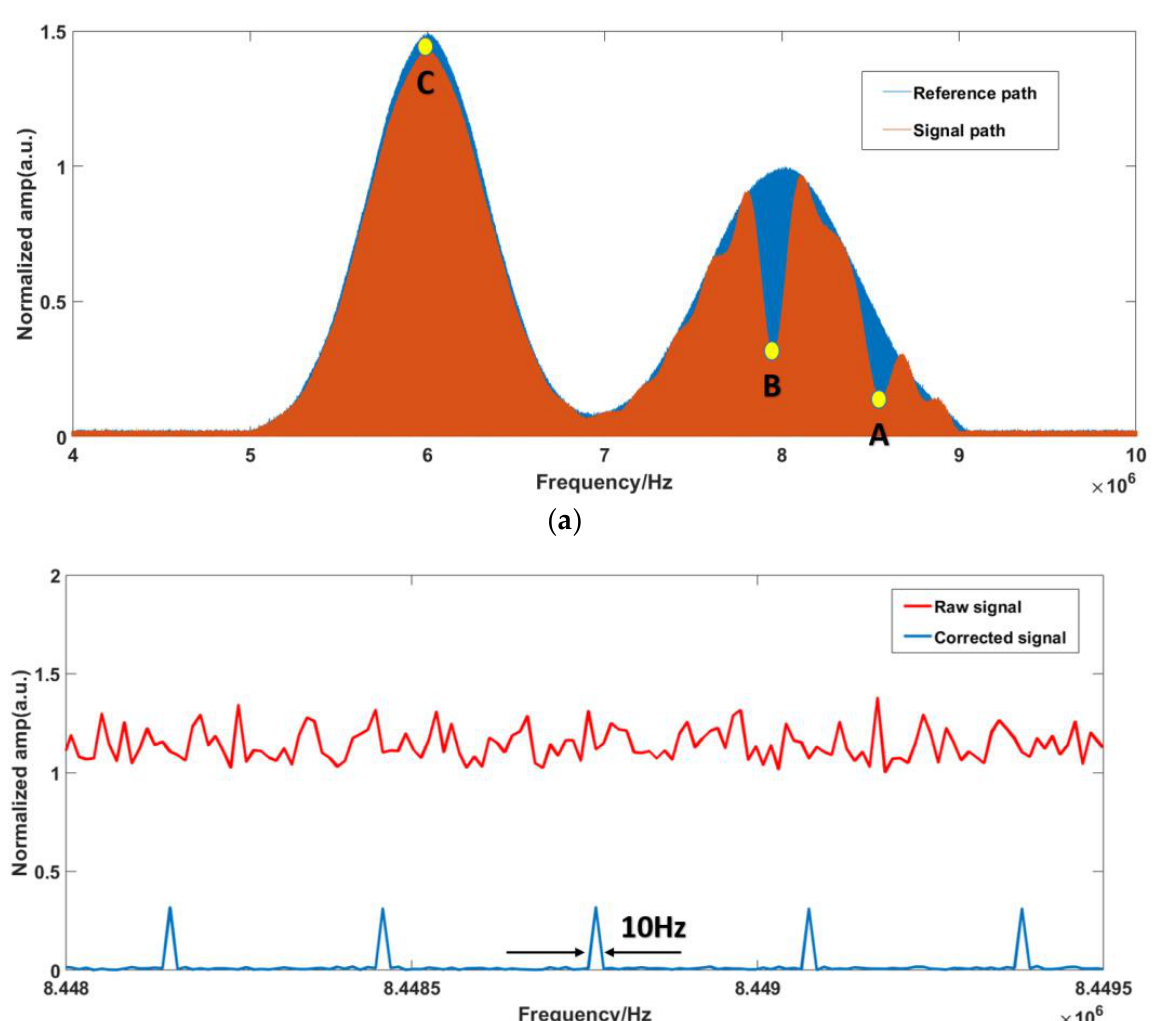
Sensors 2023 , 23 , x FOR PEER REVIEW